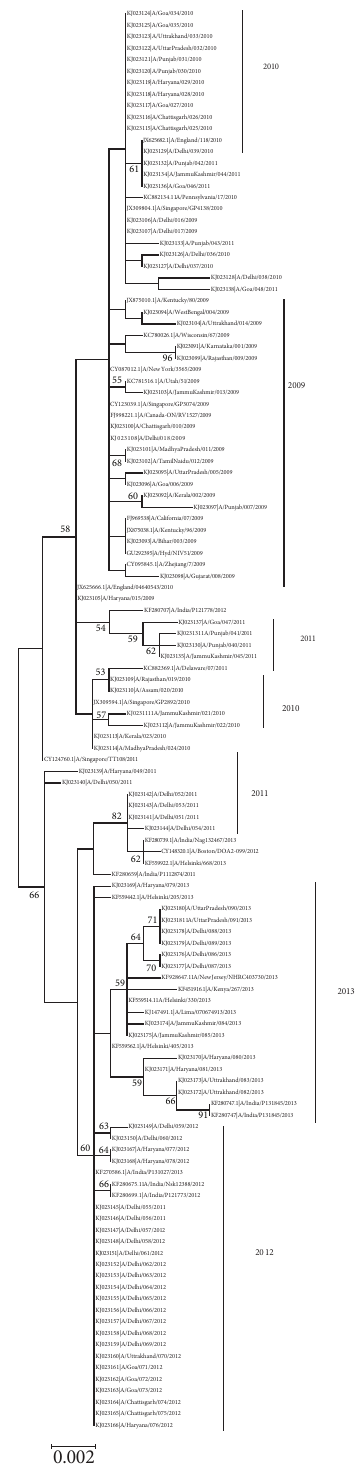
Figure 2: Phylogenetic tree of influenza A (H1N1) virus based on NS1 gene generated by the maximum likelihood method. Bootstrap support values (based on 500 replications) above 50% are shown at the branch node. Each branch is denoted by accession number and strain